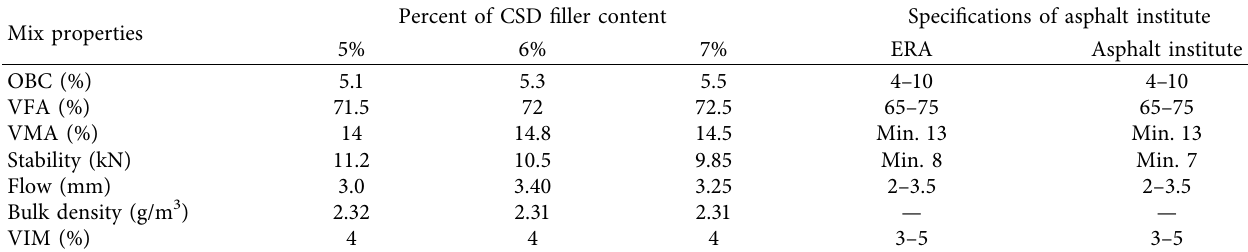
Table 8: Marshal test results for diferent percentages of CSD fller at 4% VIM.